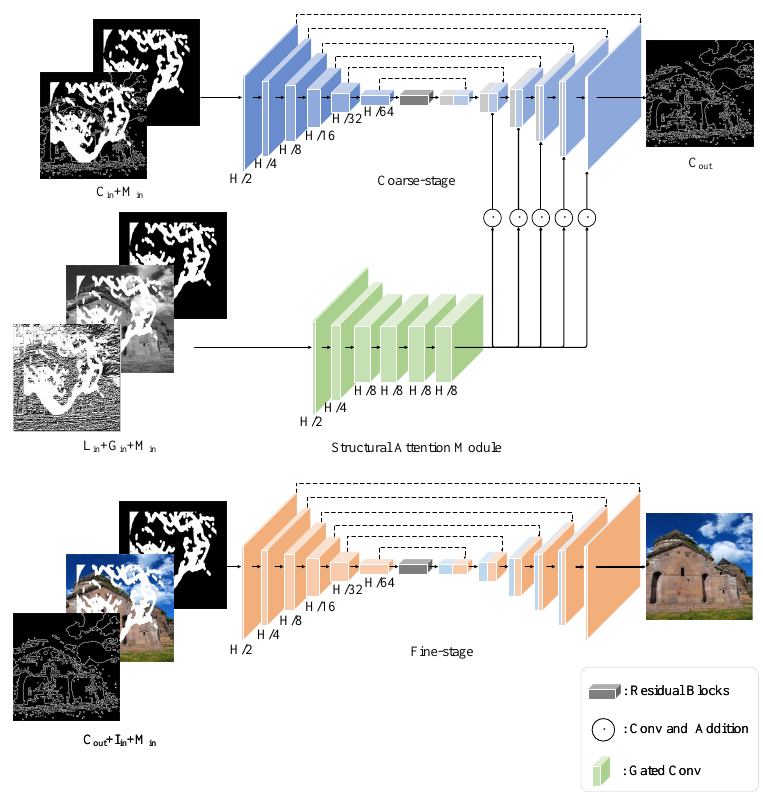
Figure 1. Generator structure diagram. The upper part is the coarse inpainting stage and structural attention module, and the lower part is the fine inpainting stage. It should be noted that the final reconstructed image in the coarse inpainting stage is the result of four rounds